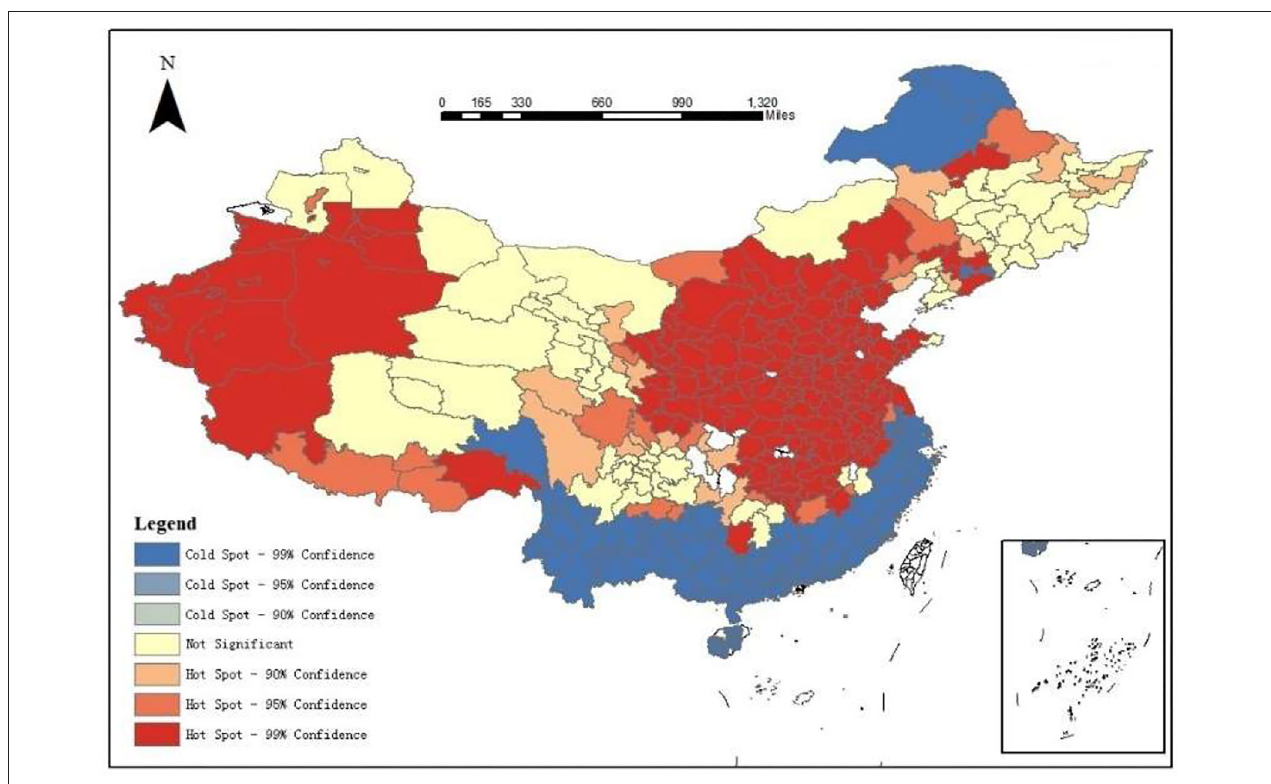
FIGURE 3 | Local Geti’s